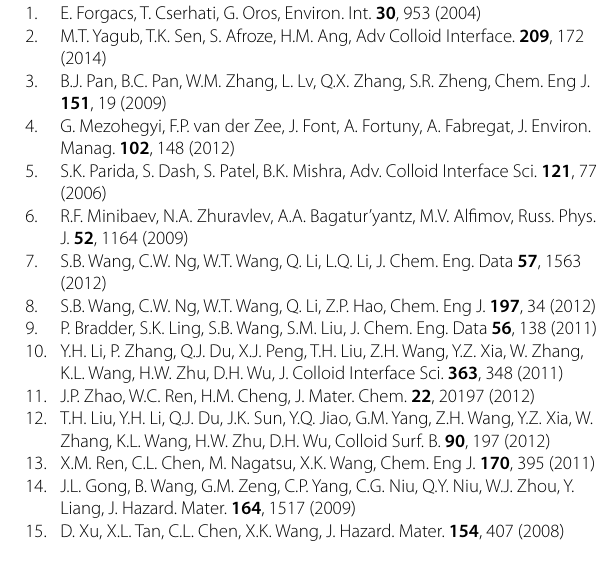
types of water contaminants. Furthermore, they show ricate a column used to purify water via simple filtra- ability remained unaltered over four successive adsorp- tion and washing cycles. Hence, the GCCHC-based